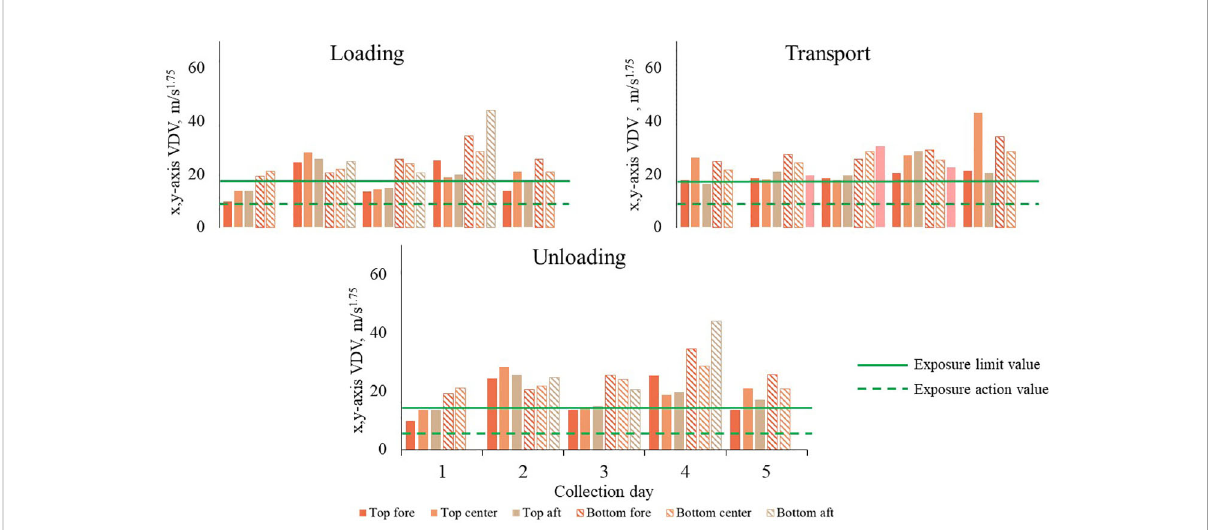
FIGURE 8 x,y-axis vibration dose value (VDV) experienced by pigs transported within two decks (DEC; T, Top; B, bottom) and three sections (SEC; F, fore; C, center; A, aft) of two trailers during loading (LOD), transport (TRA), and unloading (UDL). Least squares means encompass two daily market-weight pig loads recorded over 5 consecutive days. Exposure action value (EAV; 8.5 m/s 1.75 ; dotted green line) and exposure limit value (ELV; 17 m/s 1.75 ; solid green line) correspond to “ injury possible ” and “ injury likely ” comfort levels,